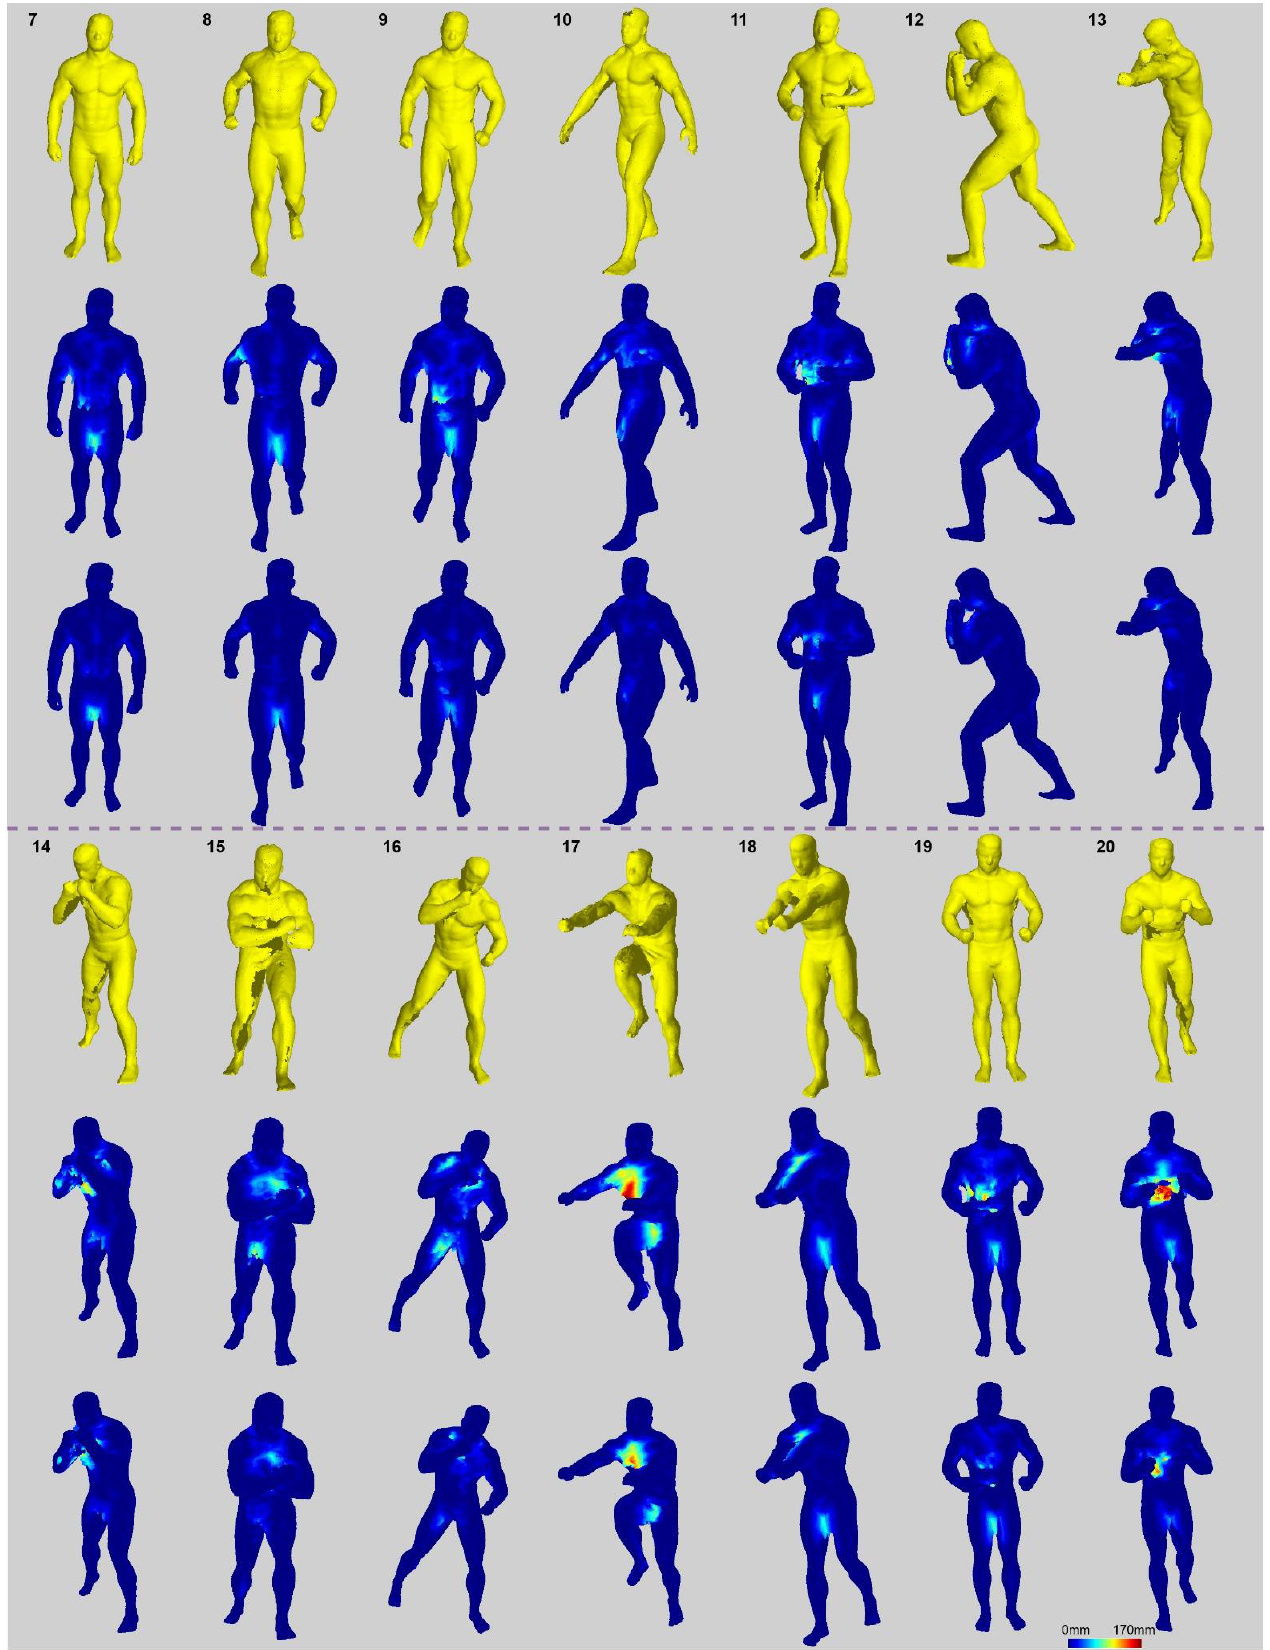
Figure A2. Visualization of the P2S distances for SfS/sSfS reconstructions for data samples #7–#20.